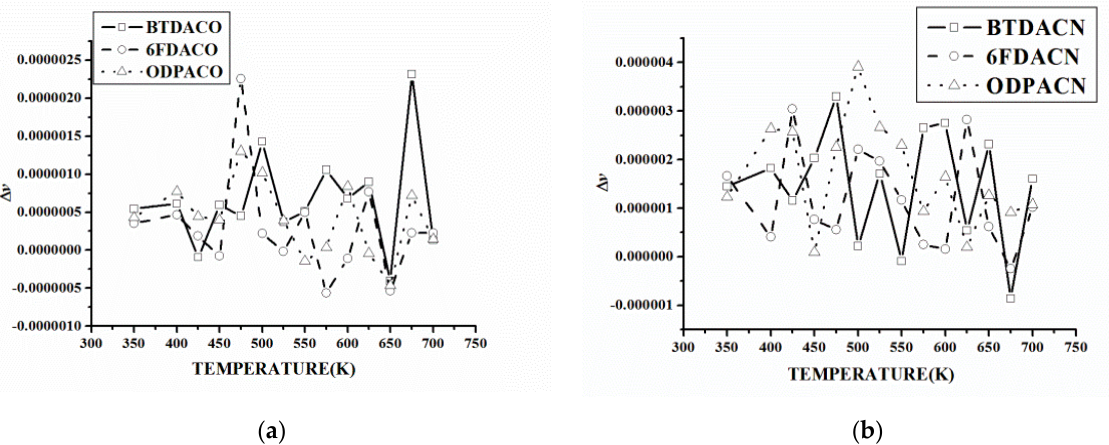
Figure 9. Comparison of Δ v values of CN and CO dihedral angles in the BTDA-APB, the 6FDA-APB, and the ODPA-APB: ( a ) CO, and ( b ) CN.